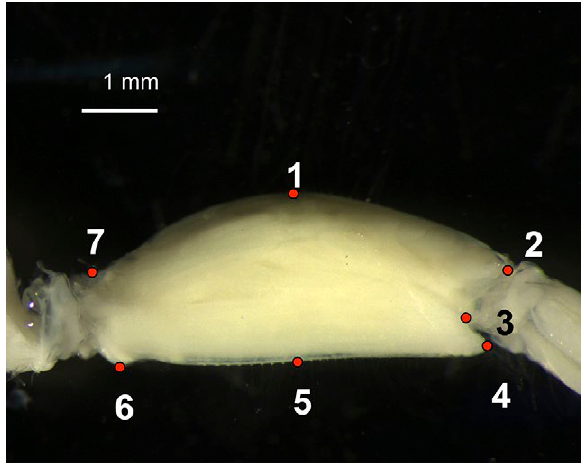
Fig. 1. – Landmark positions in the digital images obtained with stereoscope using a 16x magnifier with optical zoom. The width and length of each Pasiphaea sivado pleopod protopod were measured from the scalar distance (in mm) between the landmarks 1-5 and 4-6,